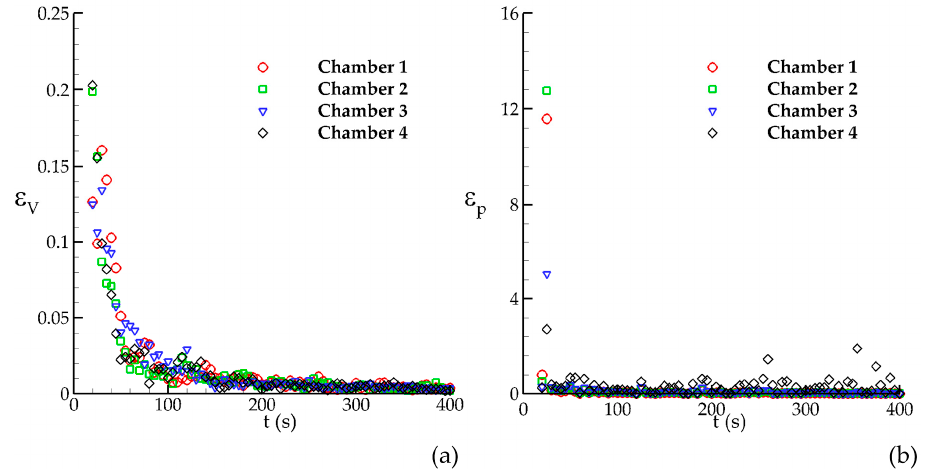
Figure 4. Variation of Euclidean norm with time on each sampling line: ( a ) mean velocity magnitude; ( b ) pressure.